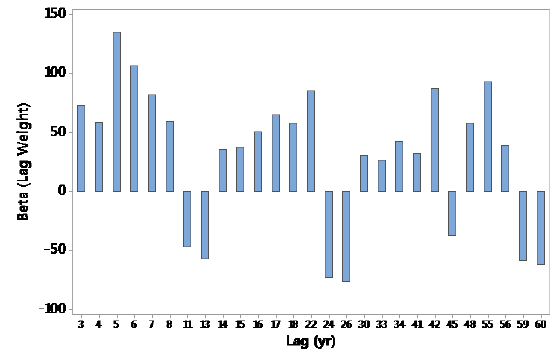
Figure 8: Estimated lag weights. Missing betas are not statistically significant